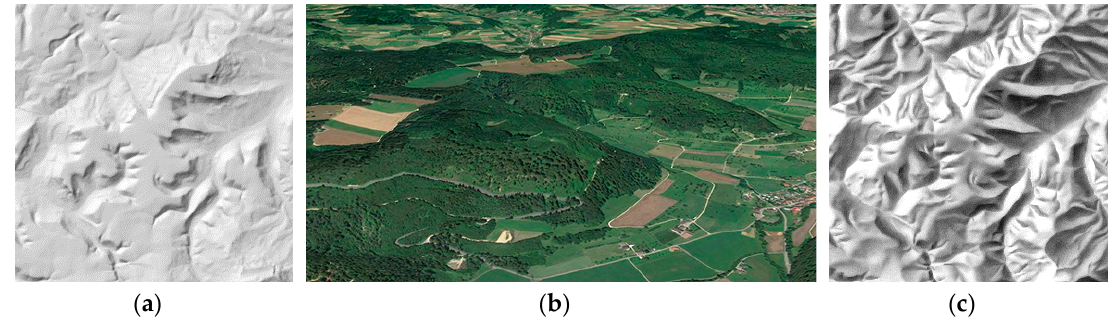
Figure 4. ( a ) The standard analytical relief shading with NW illumination of a sample area with a plateau; ( b ) an oblique view of the plateau; (c) manual relief shading of the same area by swisstopo